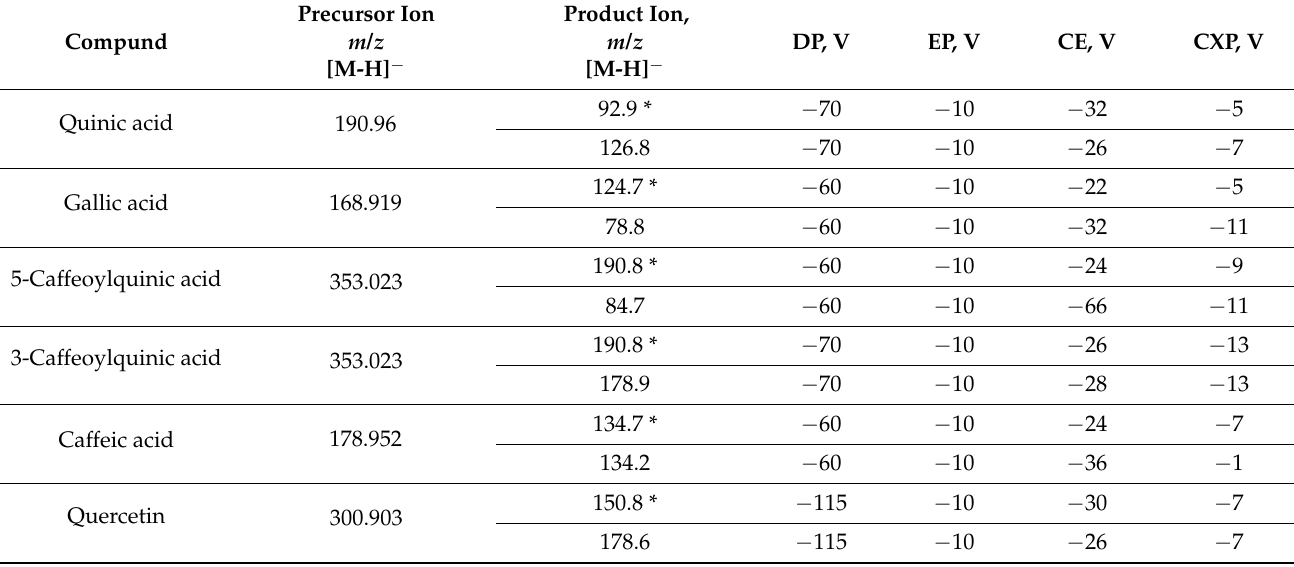
Table A1. Optimized parameters for the LC-ESI-MS/MS quantitative analysis of phenolic acids and flavonoids.